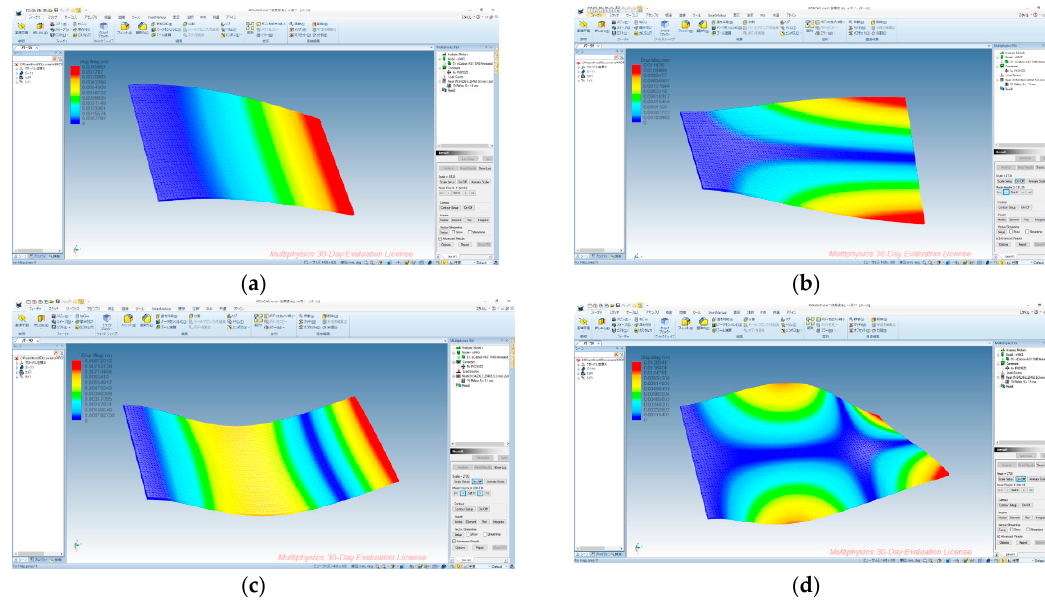
Figure 11. Results of modal analysis using finite element method. ( a ) 1st mode (42.53 Hz); ( b ) 2nd mode (182.08Hz); ( c ) 3rd mode (264.96 Hz); ( d ) 4th mode (592.54 Hz).